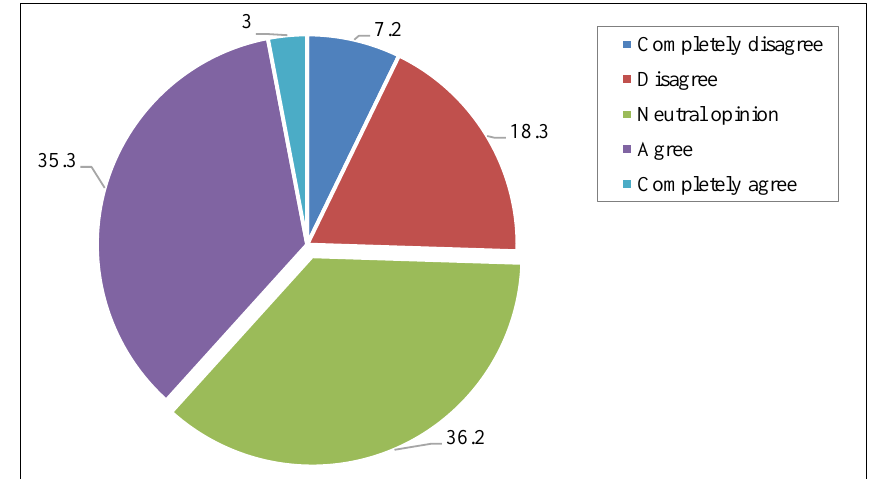
Figure 6. Enterprises enhancing the creative capacity and marketing